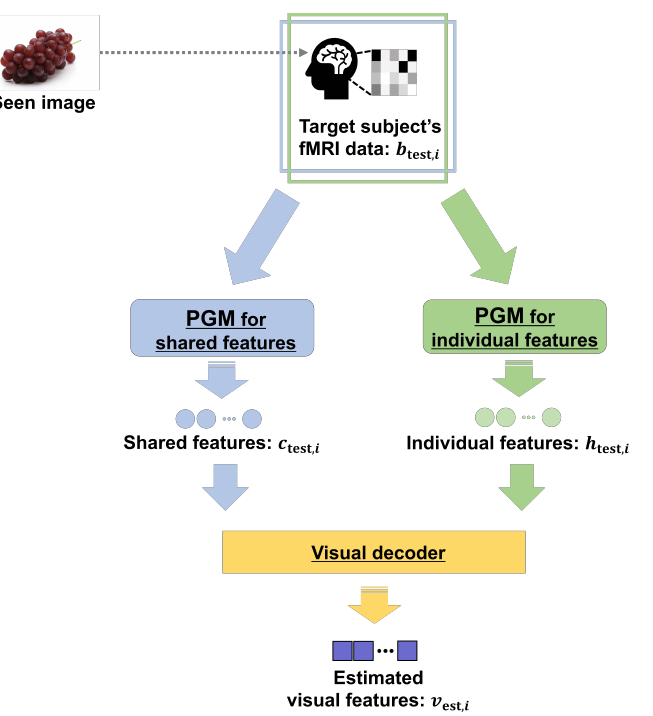
Figure 2. Overview of the test phase in the proposed method. The PGM corresponding to each feature was used to extract features from the target subject’s fMRI data. The trained visual decoder can estimate visual features using shared and individual features, and this scheme realizes our